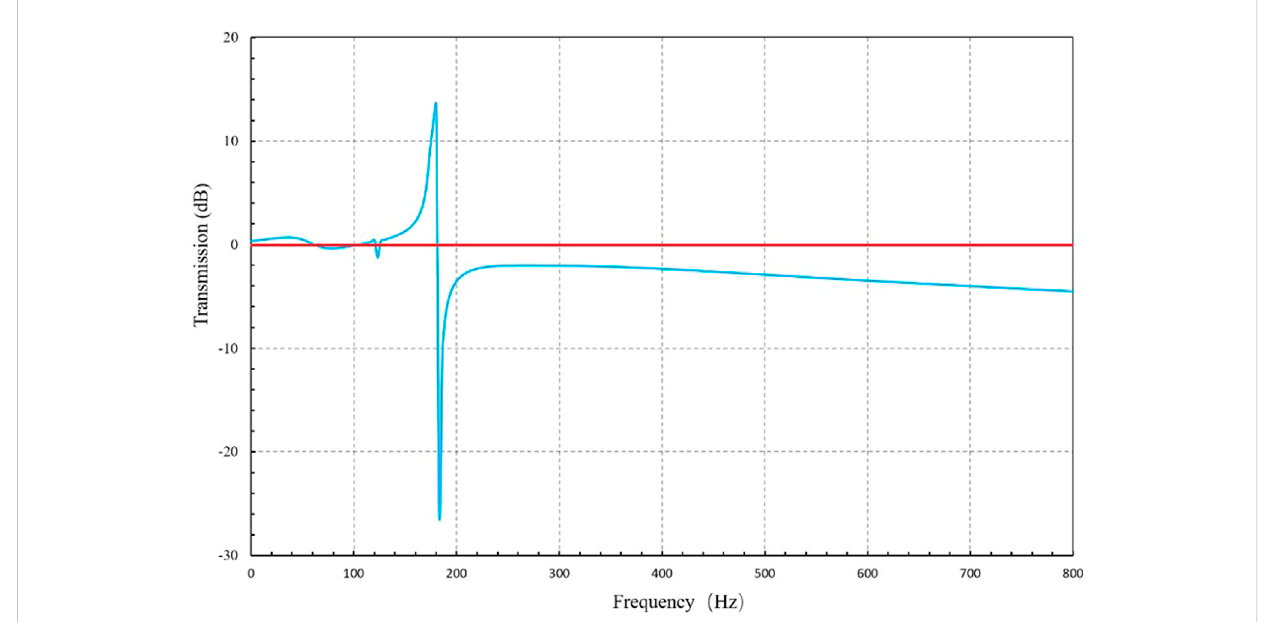
FIGURE 3 Longitudinal transmission coef fi cient of the cylindrical shell model with r 1 = 10